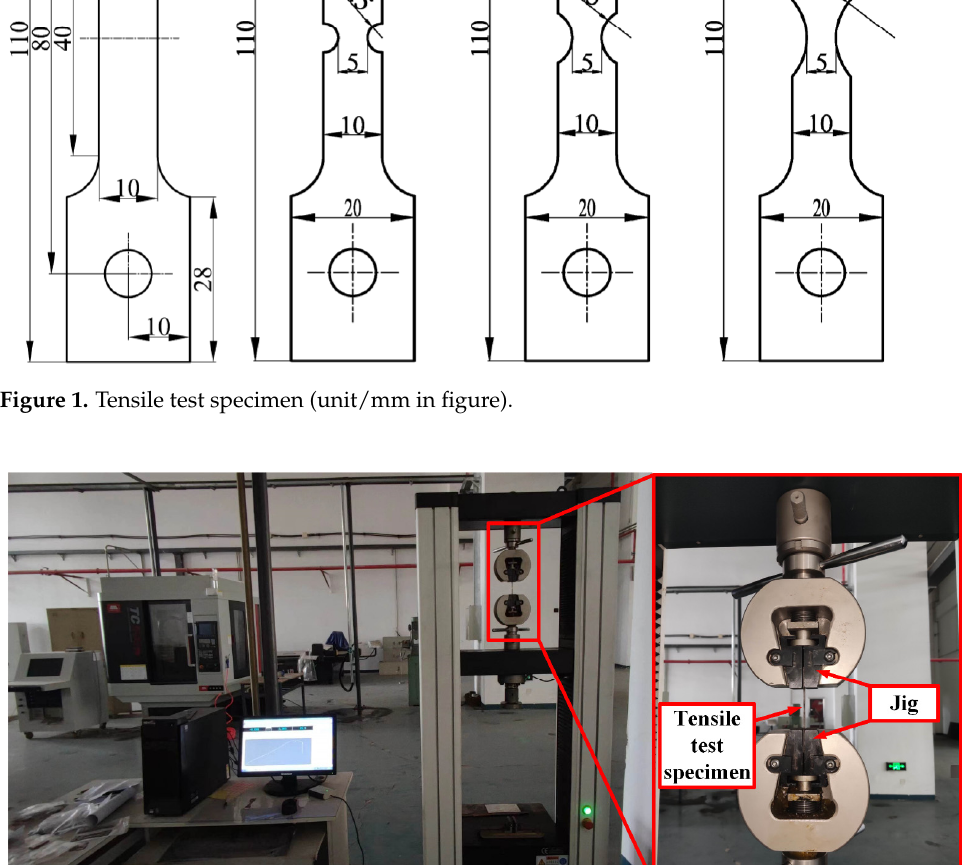
Figure 1. Tensile test specimen (unit/mm in figure).